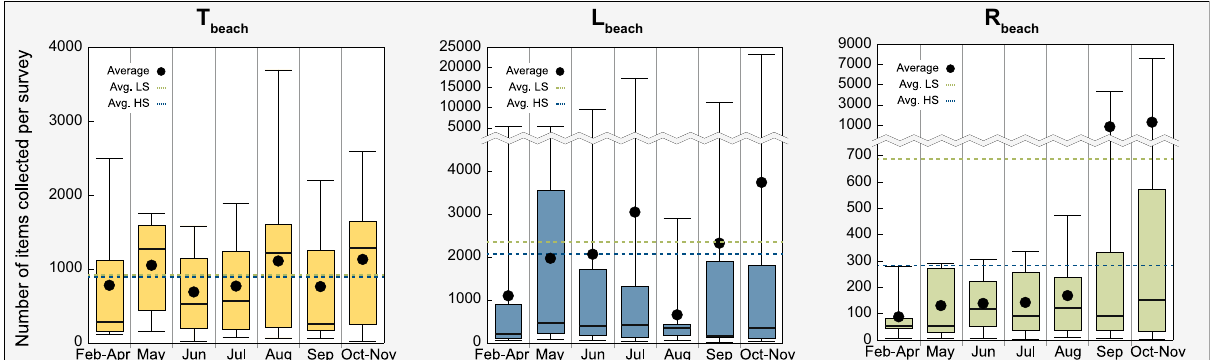
Figure 2. Number of items collected. Box plots showing the number of items collected on average per 100 m of beach (T beach in yellow, L beach in blue and R beach in green). Note that the R beach from Malta was excluded (see “Methods”). Boxes represent the limits of the first and the third quartile. The line inside the boxes is the median and the extended lines are the maximum and the minimum number of items collected (note the broken Y axis with a different scale for L beach and R beach ). Black dots: average number of items collected, green dashed line: average number of items collected during the low season (LS) and blue dashed line: average number of items collected during the high season